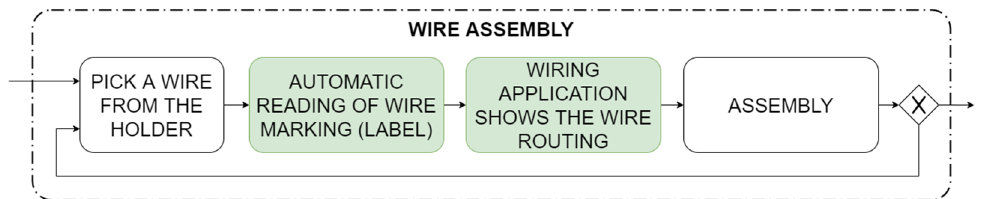
Figure 4. Wire assembly production steps in detail, with the usage of the reading prototype; green background shows the production steps that are the focus of this paper.